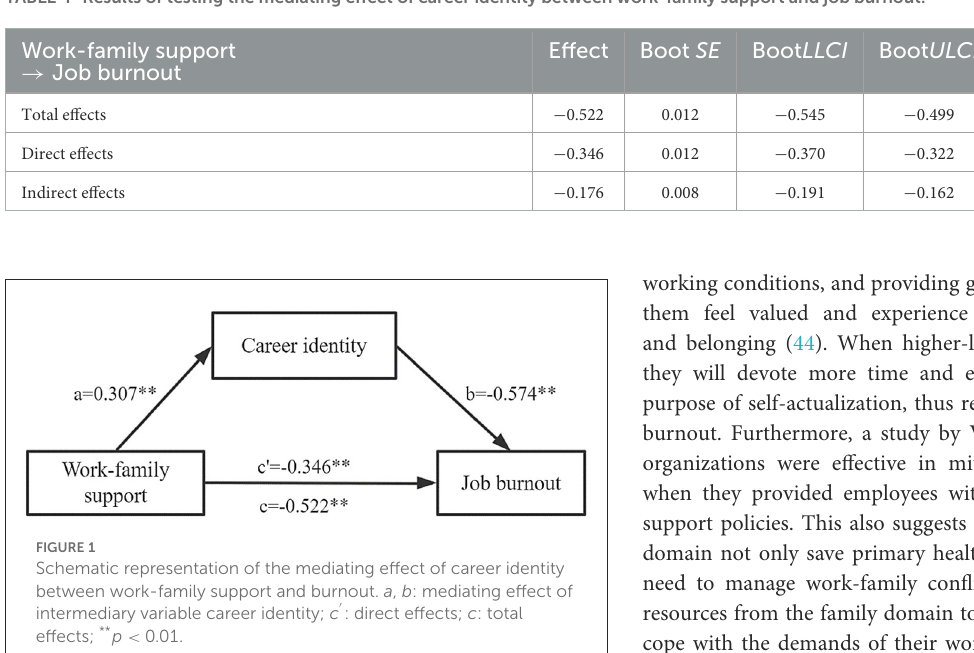
TABLE 4 Results of testing the mediating effect of career identity between work-family support and job burnout.